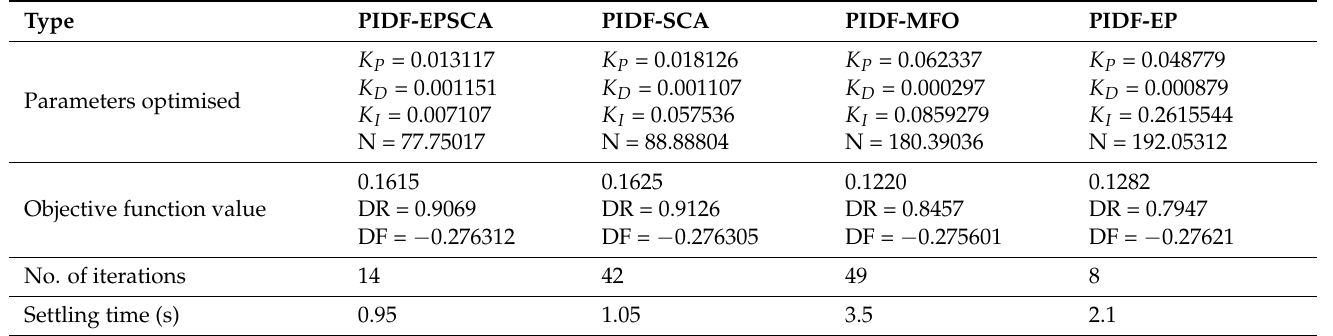
Figure 26. Eigenvalue distribution of the TCSC-PIDF controller system using PIDF-EPSCA, PIDF- SCA, PIDF-MFO, and PIDF-EP techniques for Scenario A-4. Table 6. Comparison of PDF-EPSCA, PIDF-SCA, PIDF-MFO, and PIDF-EP for Scenario A-4.